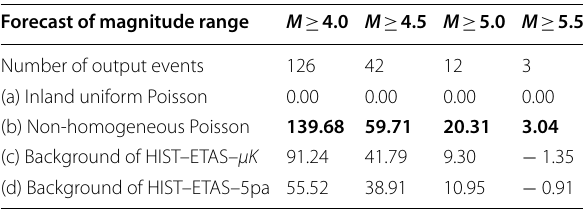
These are the scores of the forecasting of earthquakes of respective magnitude ranges; scores are relative to those of the “inland uniform Poisson” model